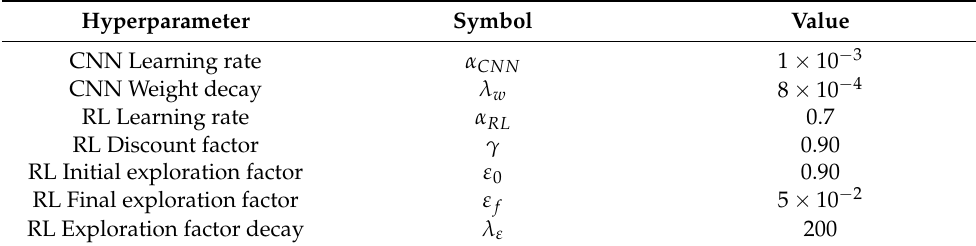
Table 1. Hyperparameters used in the RL and CNN models during